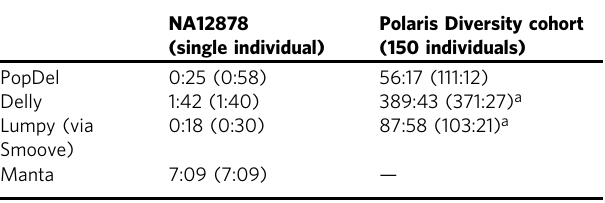
Table 2 Running times (wall clock time, CPU hours in parentheses) on NA12878 and the Polaris Diversity cohort.